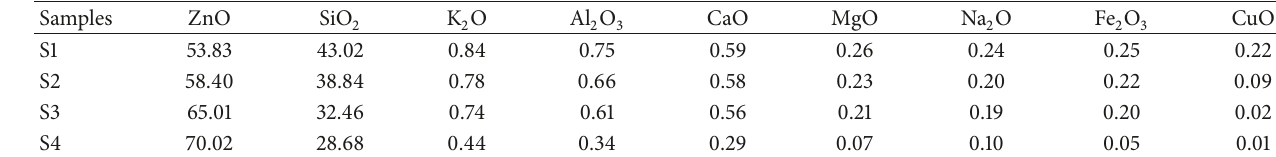
Table 1: Analysis of chemical composition of ZnO–SiO 2 samples.